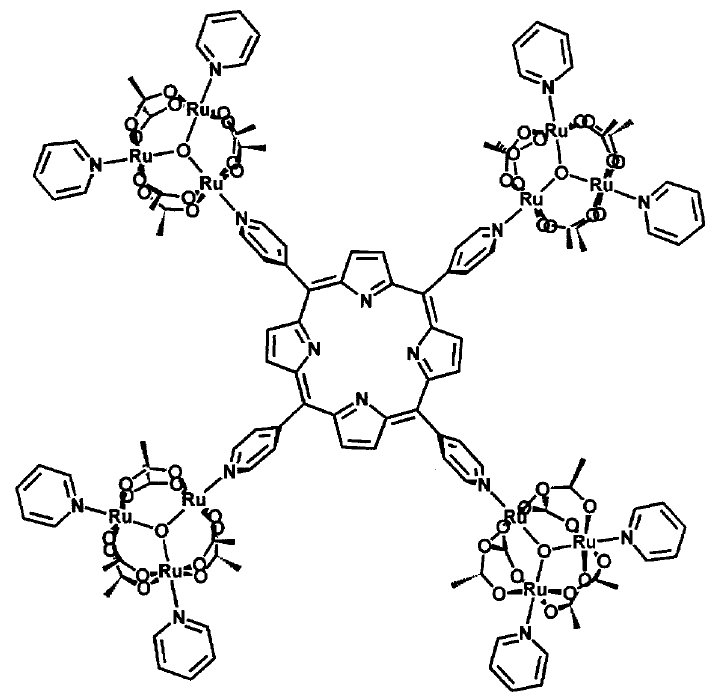
Fig. 8 – Structural representation of a dodecanuclear cluster-porphyrin